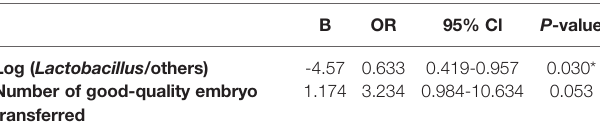
TABLE 4 | Multivariate logistic regression assessing the association of the number of good-quality embryos transferred and microbiota composition with clinical